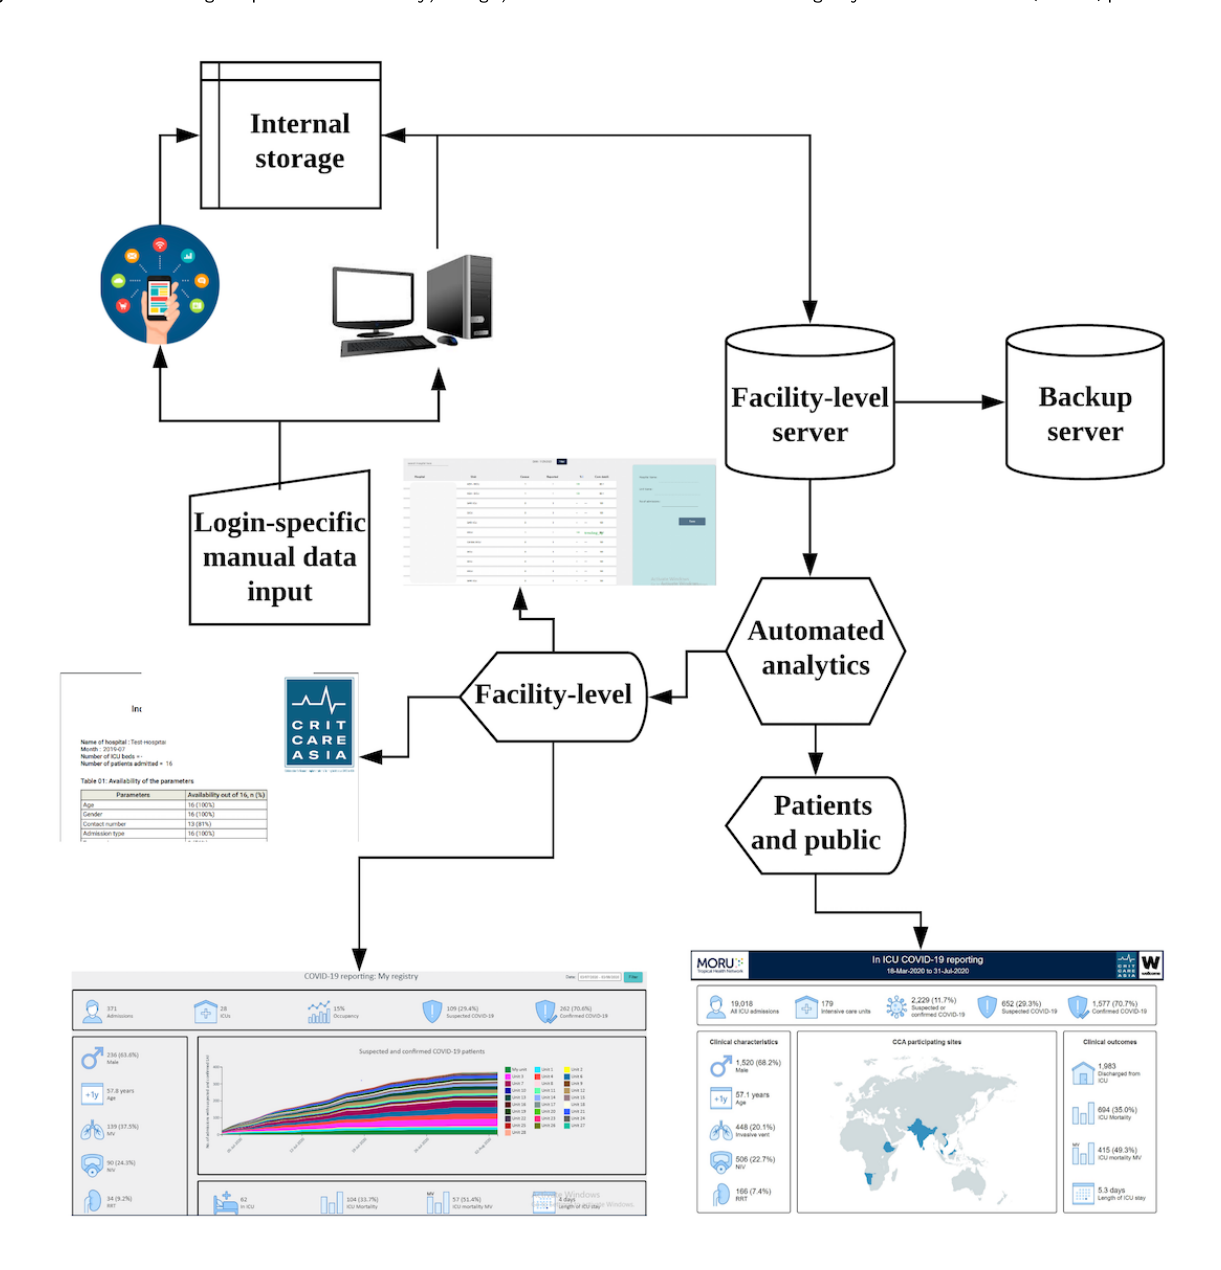
Figure 1. Scheme outlining the process of data entry, storage, and visualization in the Pakistan Registry for Intensive CarE (PRICE)